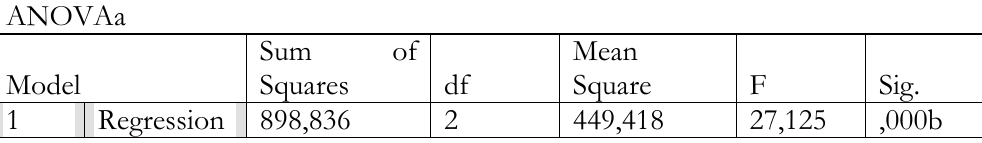
Table 4 F Test Results